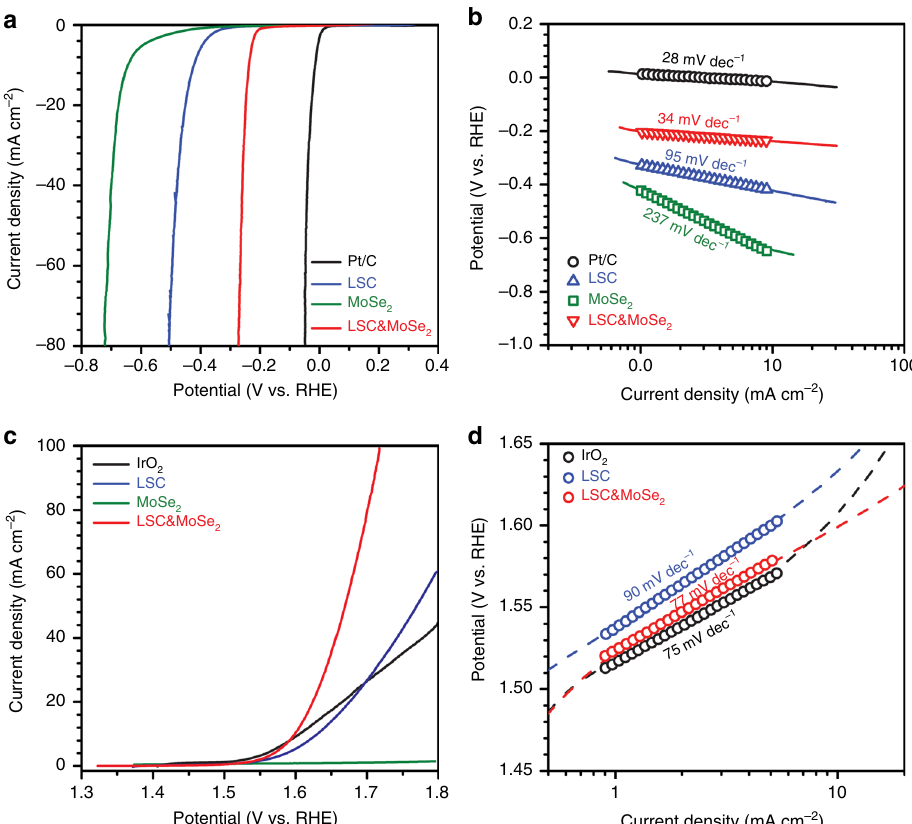
Fig. 2 Half-cell-con fi gured hydrogen evolution reaction and oxygen evolution reaction pro fi les. a HER polarization curves of various catalysts measured in N 2 -saturated 1 M KOH. b Tafel analysis of the HER pro fi les. c OER polarization curves of various catalysts. d Tafel plots derived from the RDE pro fi